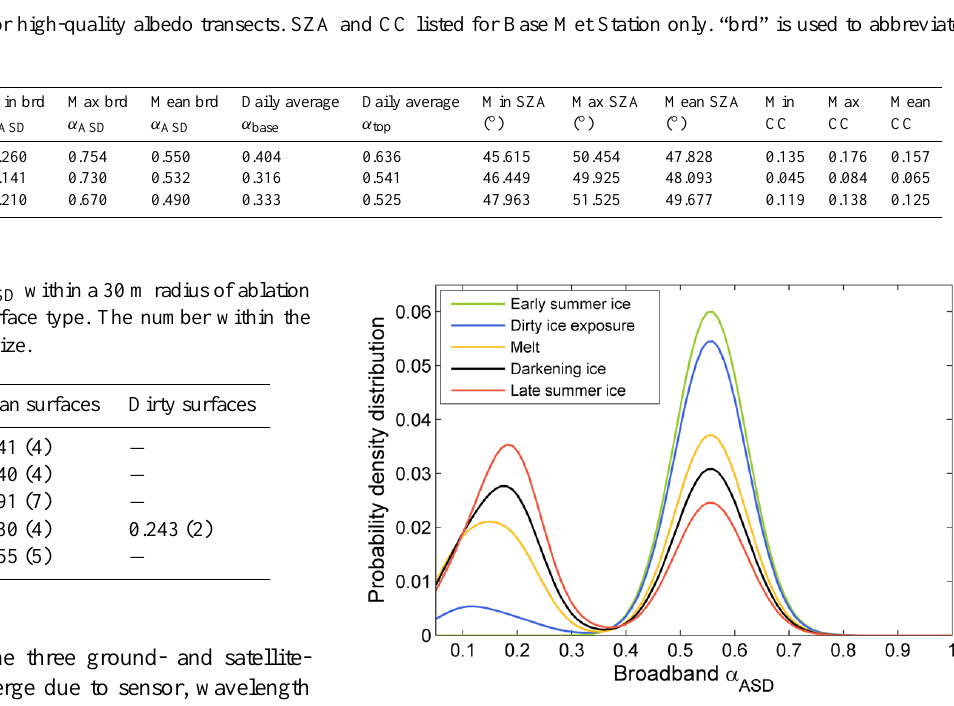
Figure 4. Computed albedo distribution for a nearby site of Chandler et al. (2015) simulated across the melt season based on observed broadband α ASD values for dominant surface types, weighted by their relative surface area coverage. Each surface type is assumed to follow a normal distribution. Computed albedo distri- butions represent the sum of each surface type’s probability distri- bution